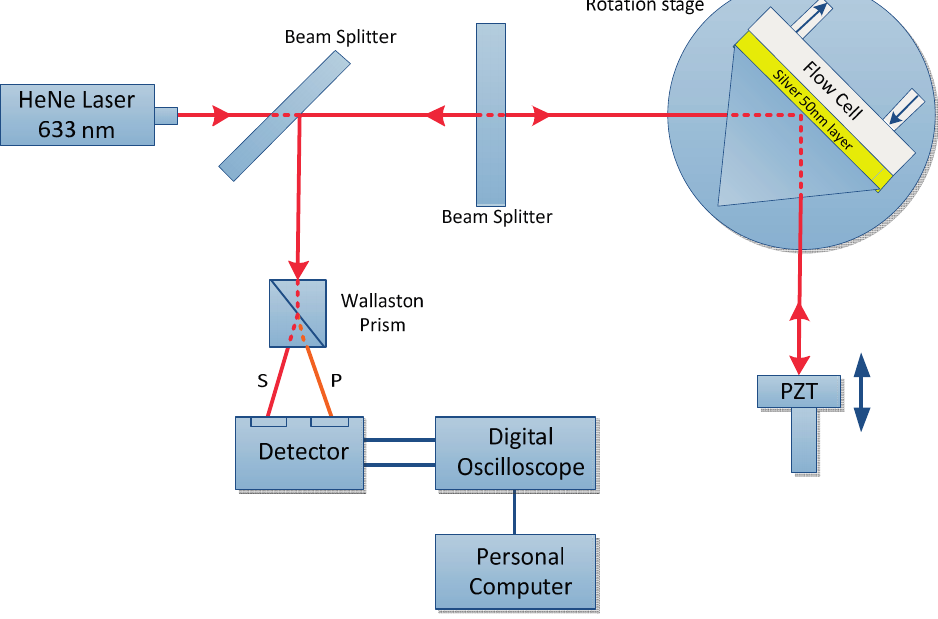
Figure 4. FPI optical configuration used to measure the differential SPR phase